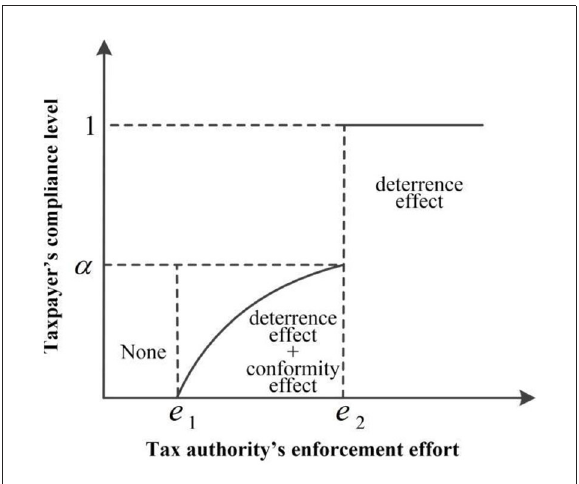
FIGURE4 The relationship between the tax authority’s enforcement effort and the taxpayer’s compliance